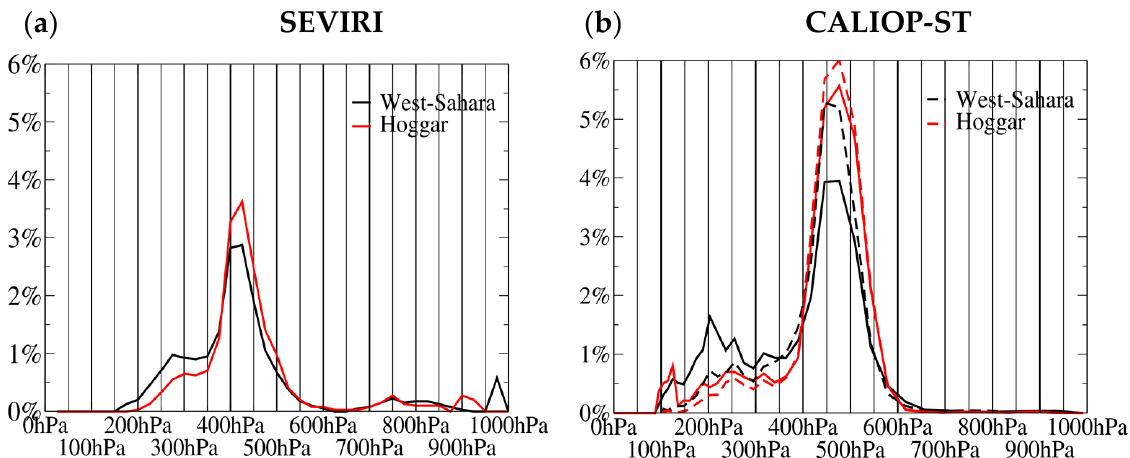
Figure A1. ( a ) Occurrence frequency distributions of Spinning Enhanced Visible and Infrared Imager (SEVIRI) cloud top pressure for West-Sahara (black line) and Hoggar (red line). ( b ) CALIOP-ST (CALIOP Science Team) cloud pressure occurrence frequency distributions of the cloud top (dashed line) and for the pressure level inside the cloud when the optical thickness reaches 0.3 (solid line) for West-Sahara (black line) and Hoggar (red line).